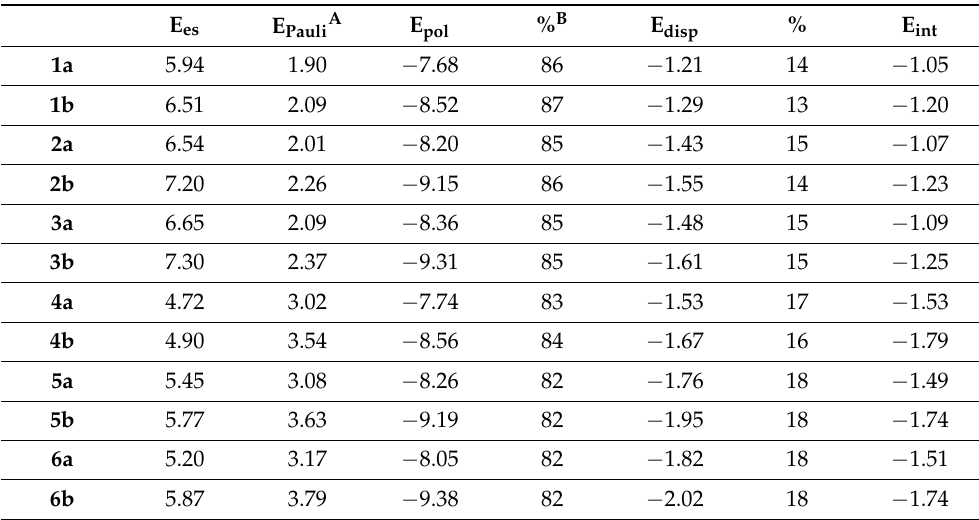
Table 5. LMOEDA/MP2/aug-cc-pVDZ decomposition of the interaction energy in water of com- plexes into electrostatic (E es ), Pauli repulsion (E Pauli ), polarization (E pol ) and dispersion (E disp ) components. All quantities in